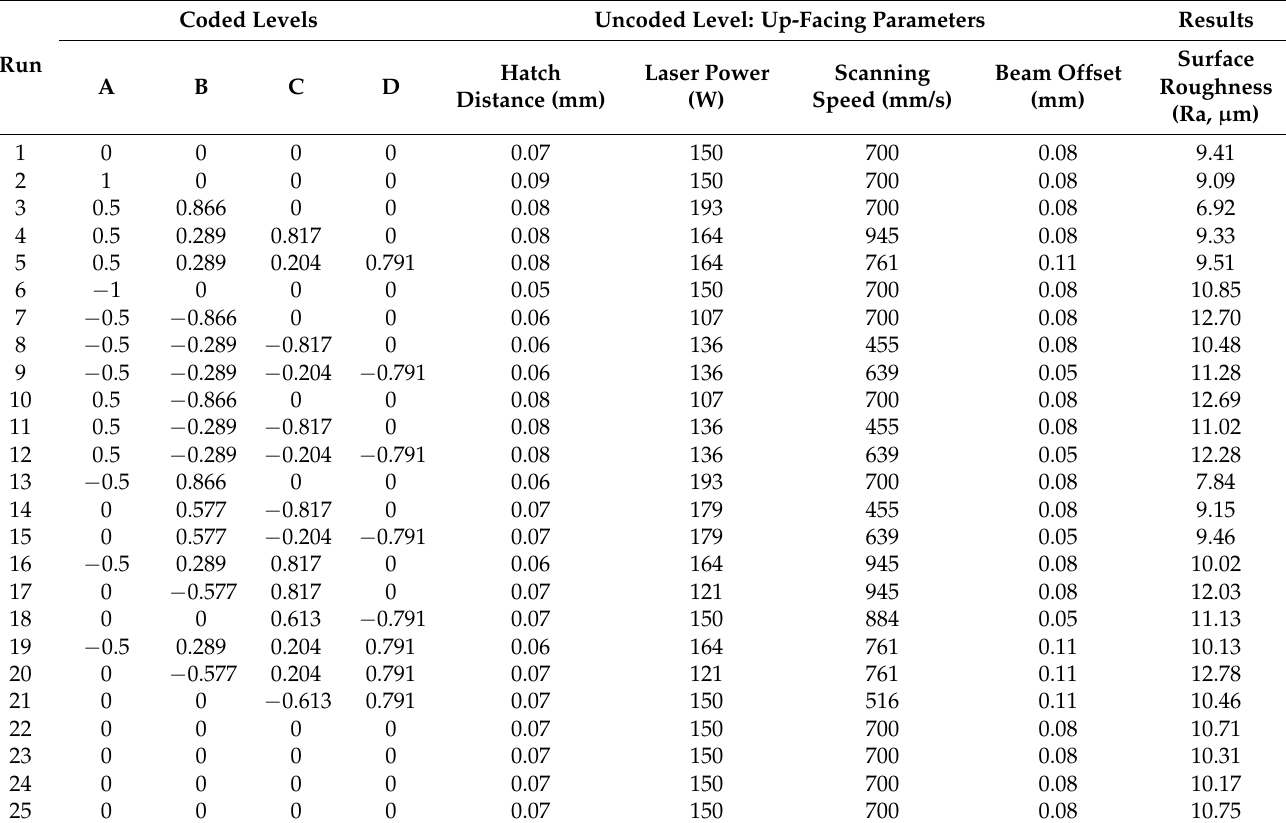
Table 6. The Doehlert matrix and experimental results of up-facing surface